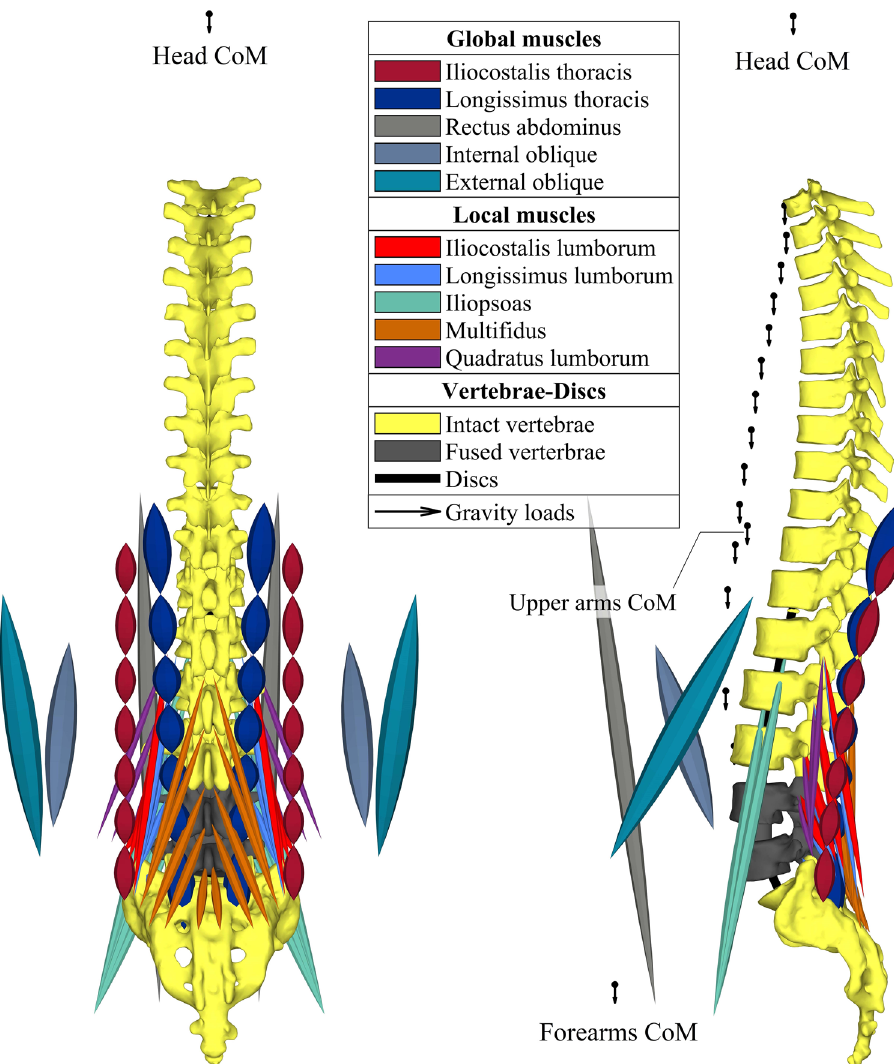
Figure 2. A schematic of the musculoskeletal (MS) model with the trunk (10 global and 46 local) musculature in (left) the frontal (back view) and (right) sagittal (left view) planes. The L4 and L5 vertebrae that are interconnected by the L4-L5 disc in the intact model are instead fused in the post-fusion model (highlighted here in dark